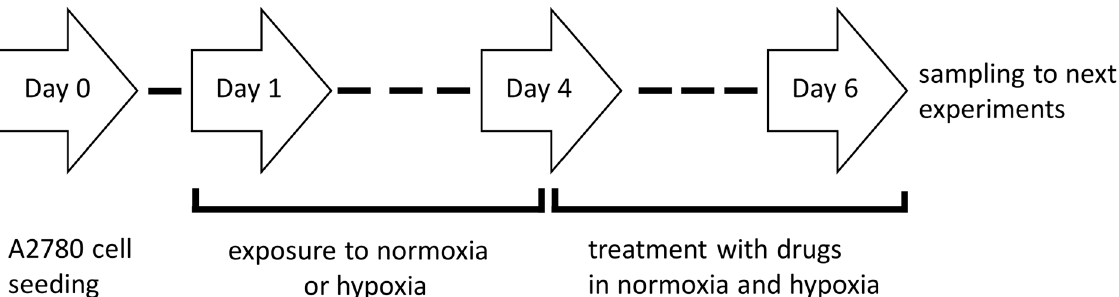
Figure 9. The protocol scheme for cell adaptation to experimental conditions.